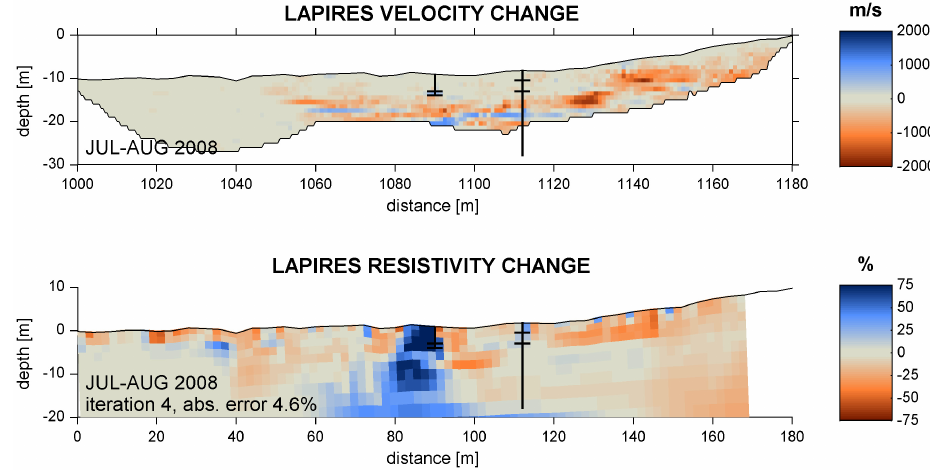
Fig. 9. Comparison of temporal change in seismic velocities with resistivity changes. Locations of the pylon and the borehole are indicated, as well as the respective thaw depths for both